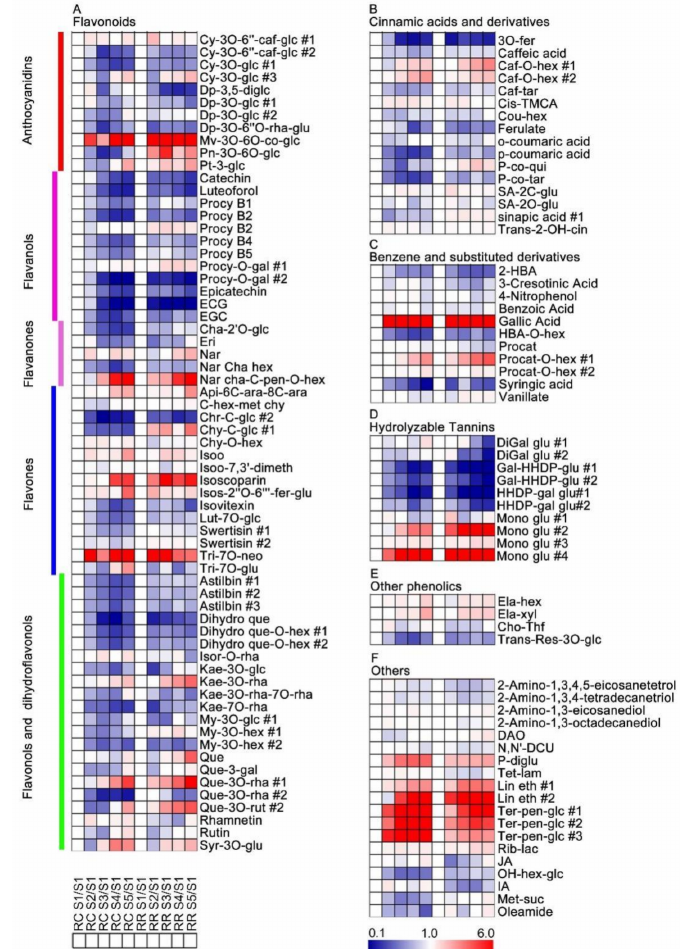
Figure 3. Heatmap of the secondary metabolite changes in pulp tissues of developing berries for each cultivation method as compared with S1 stage. ( A ) Flavonoids, including anthocyanins, fla- vanols, flavanones, flavones and flavonols and dihydraflavonols; ( B ) cinnamic acids and derivatives; ( C ) benzene and substituted derivatives; ( D ) hydrolysable tannins; ( E ) other phenolics; ( F ) others. RR and RC are the abbreviations of root restriction and traditional cultivation, respectively. A t -test was performed for statistical analysis. Each data was the mean value of three biological replicates. The full names of metabolites are attached to Supplementary Table